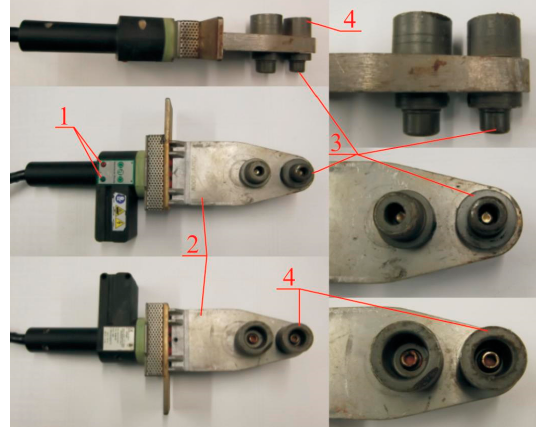
Figure 2. Polyfusion welder: 1–temperature signal lamps; 2–heating plate; 3–heating mandrel; 4–heating sleeve.